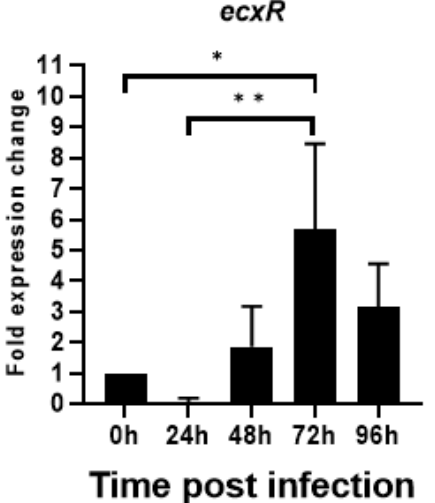
Figure 6. Total RNA recovered from synchronously cultured E. chaffeensis in DH82 cells at different time points were used to perform real-time RT-PCR analysis for ecxR gene and normalized against bacterial 16S rRNA. Relative values to the amount at 0 h p.i. are shown. Data indicate mean values ± standard deviations from three independent experiments performed in triplicates. Statistical significance was determined by one-way analysis of variance (ANOVA) followed by Tukey’s multiple- comparison test (* p < 0.05; ** p < 0.01).